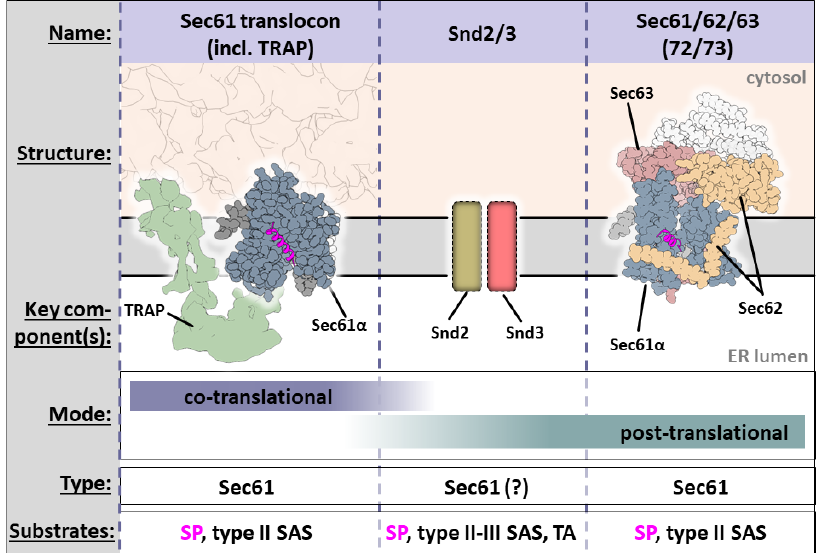
Figure 4. ER translocation and insertion machineries for SP-containing proteins. Left upper panel: The Sec61 translocon comprises, among others, the ribosome (shown in the cytosolic background), Sec61 (Sec61 α blue, Sec61 β dark gray, Sec61 γ light gray), and the yet structurally uncharacterized TRAP (green EM map). The structure is a composite of EMDB 4315 [90] and PDB 3JC2 [92]. Middle upper panel: The yet structurally uncharacterized Snd2/3 membrane complex [15]. Right upper panel: S. cerevisiae Sec61 opened by Sec62 (light teal), Sec63 (dark teal), and the yeast-specific Sec71/72 (white). The structure is a composite of PDBs 7AFT and 6ZZZ